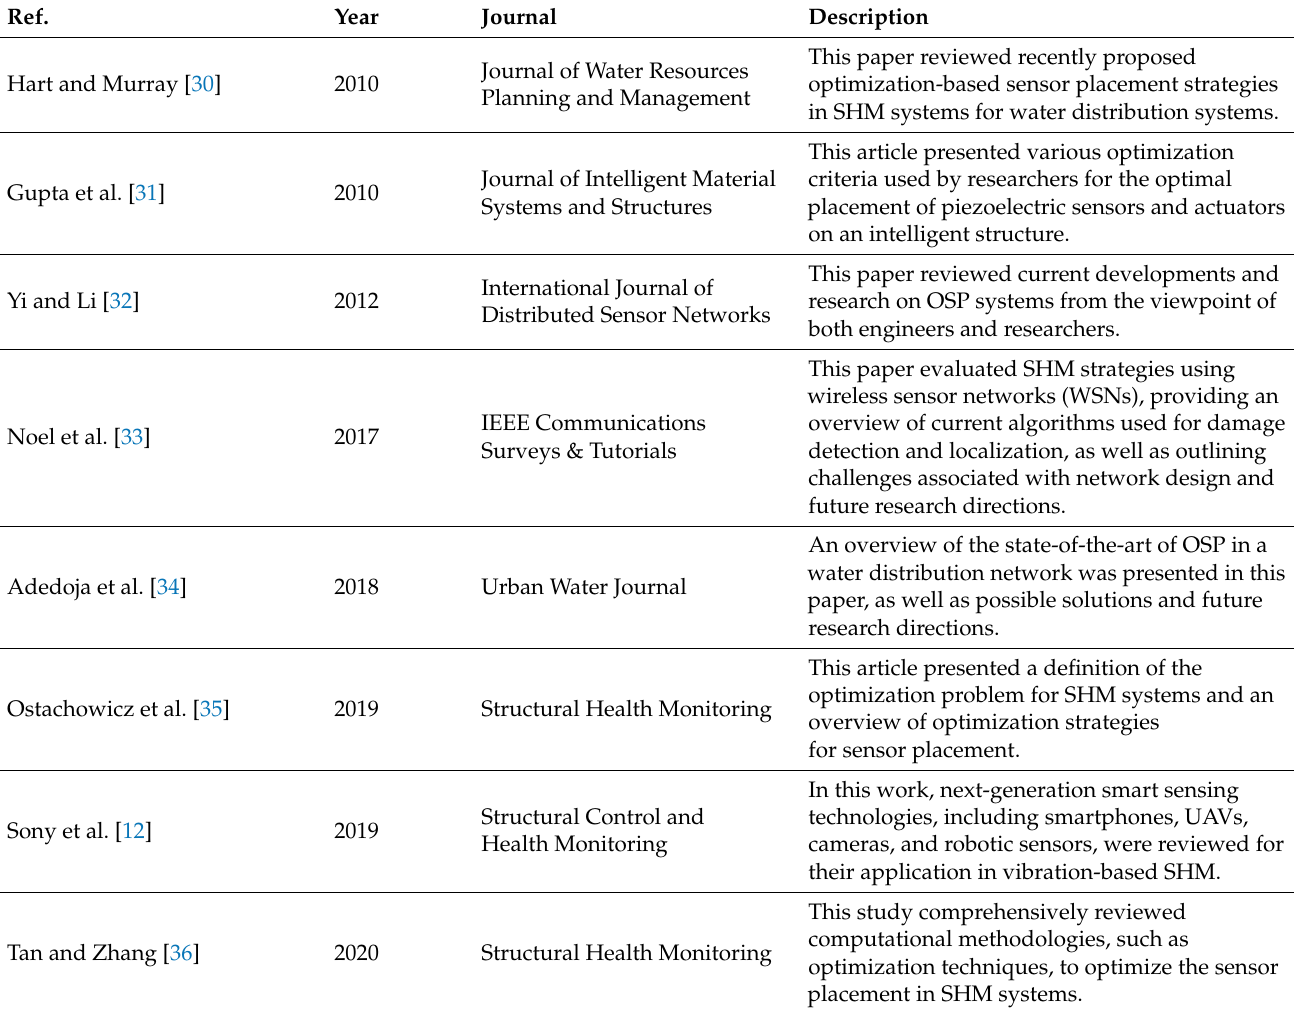
Table 2. Review papers on optimization algorithms for SHM systems (between 2010–2023).